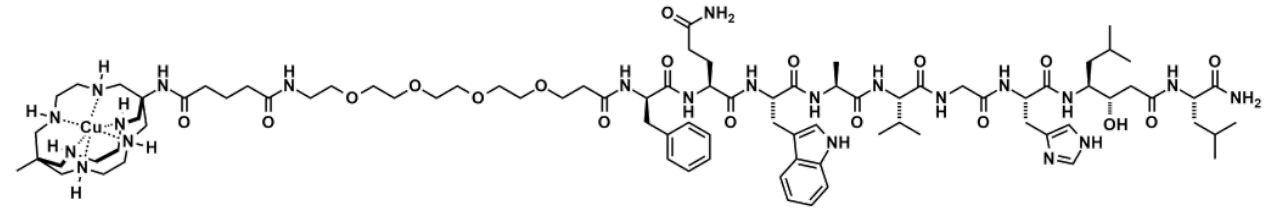
Figure 1. The structure of [ 64/67